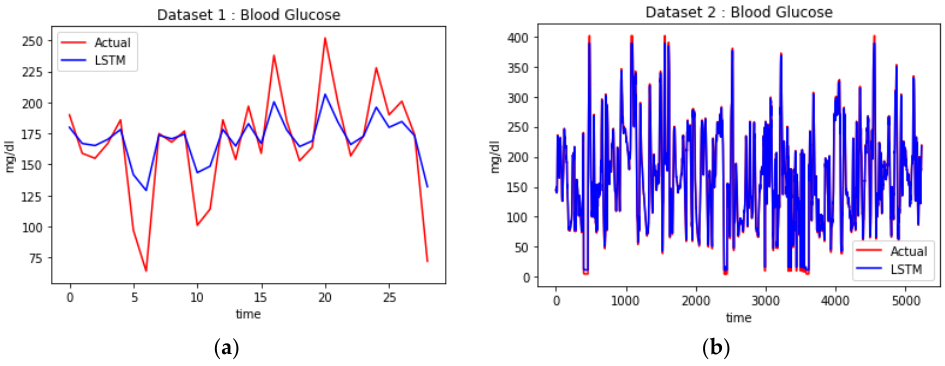
Figure 9. BG prediction based on LSTM for first ( a ) and second dataset ( b ).